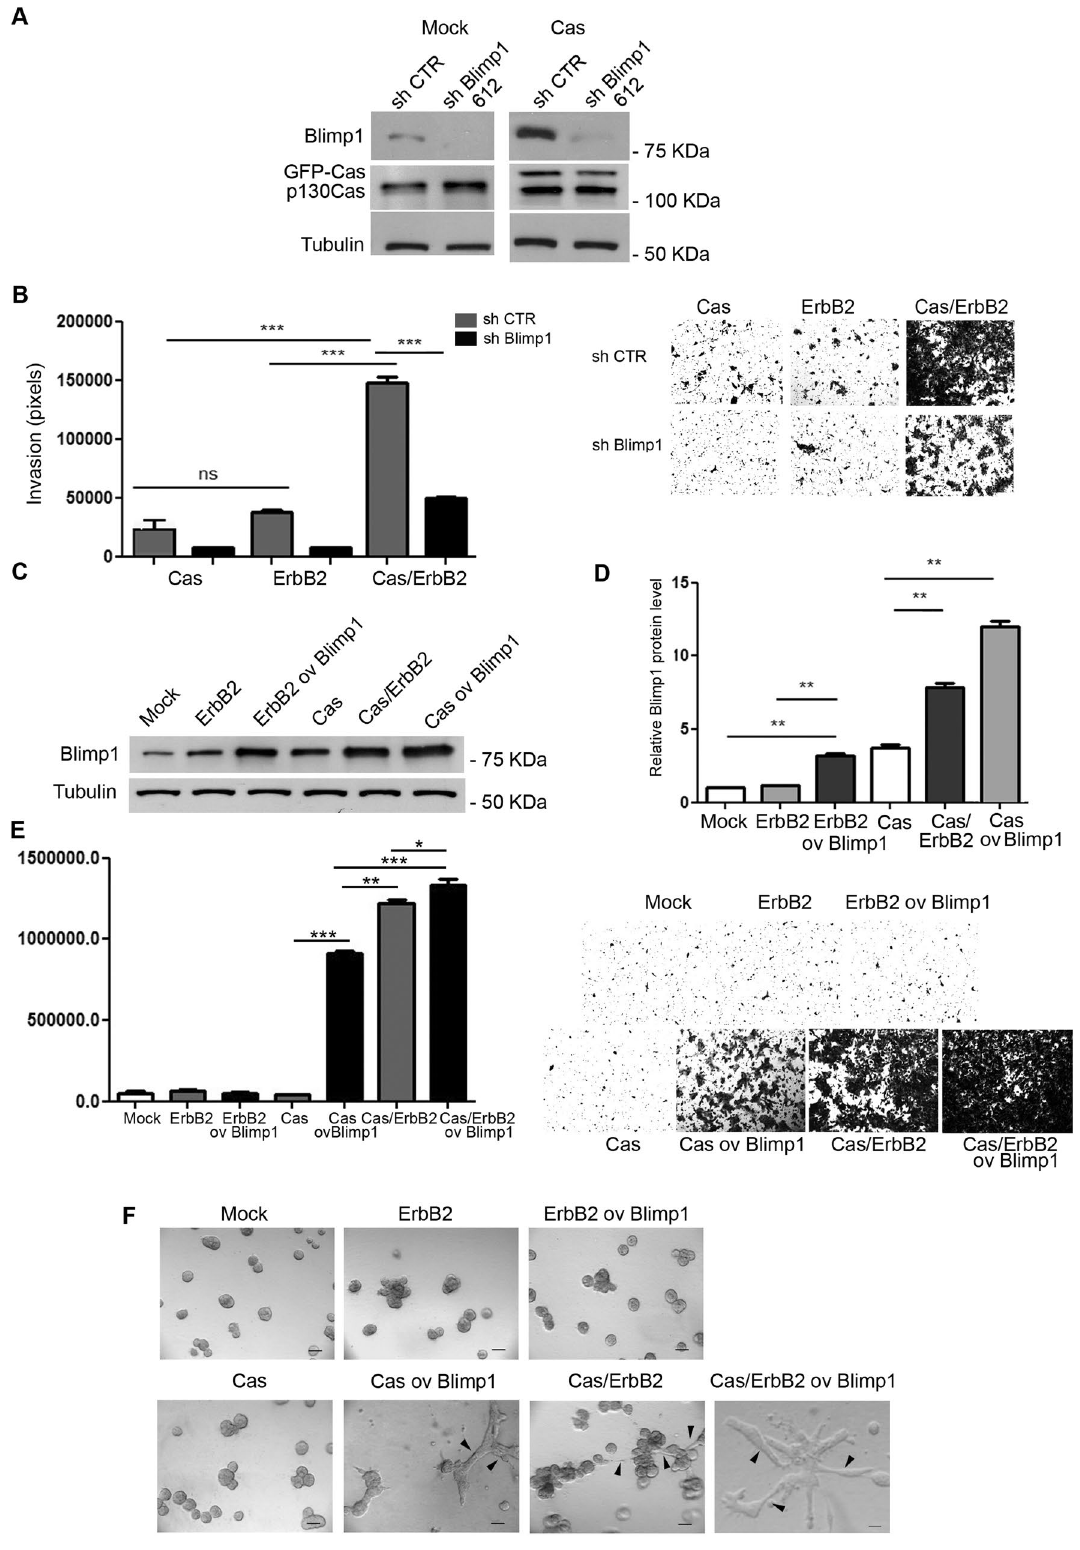
Figure 2. Blimp1 expression modulation influences migratory capacity in 2D and 3D cultured cells. ( A ) Mock and Cas cells were transduced with the sh Blimp1 clone 612 vector and the Blimp1 and p130Cas protein levels were evaluated using western blot analysis. Tubulin was used as the loading control. ( B ) Mock and Cas cells, that had either been transduced with human sh Blimp1 clone 612 vector or scrambled ctr vector, were subjected to transwell invasion assays for 48 hours both in the presence and absence of 1 µ M AP1510. Cell invasion quantification was performed over three different experiments. Results are presented as mean ±